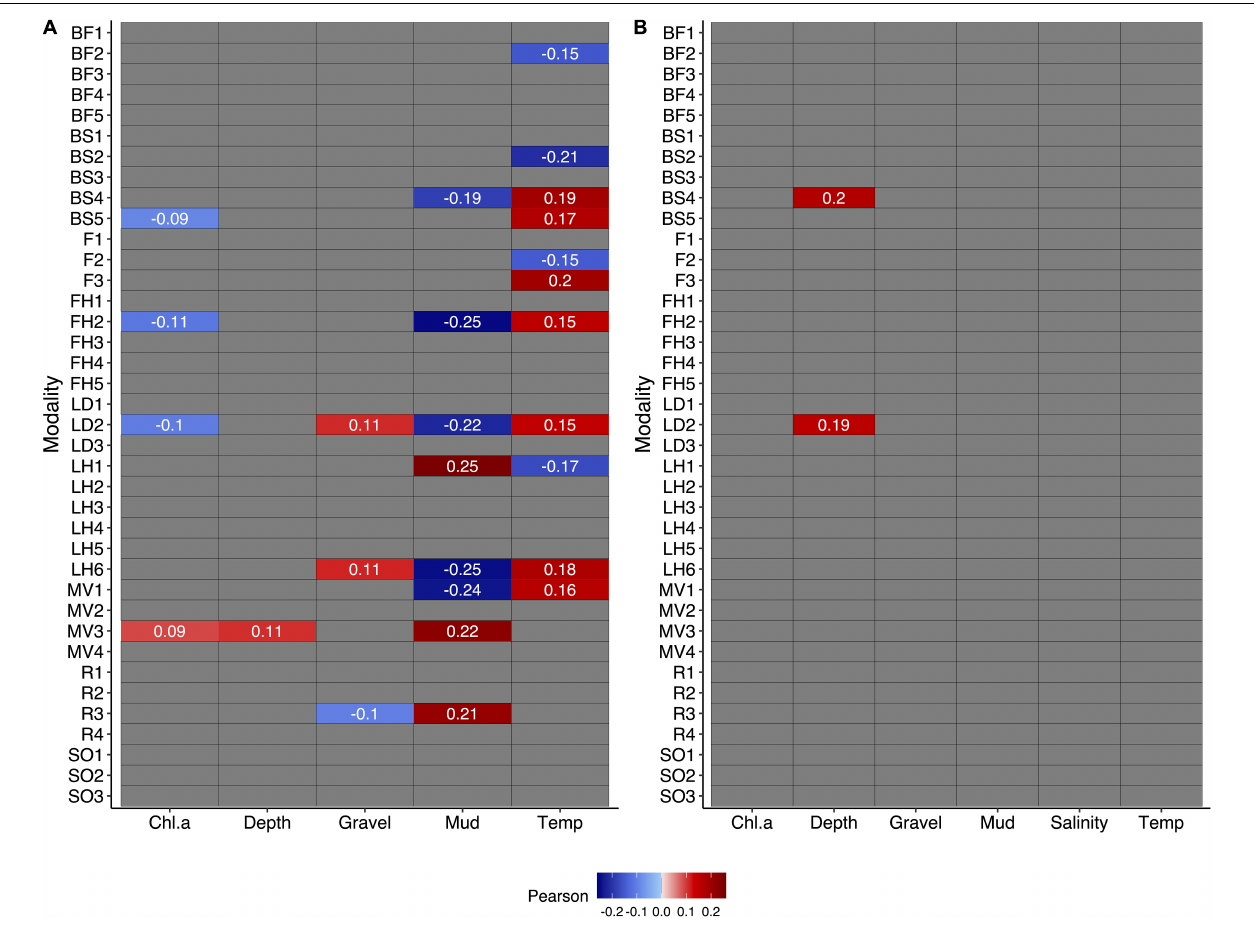
FIGURE 3 | Fourth corner tests show significant bivariate relationships between modalities and environmental variables for the Chukchi Sea (A) and the Beaufort Sea (B) . Significant positive relationships are represented by red colors and significant negative relationships are represented by blue colors. Gray colors indicate no significant relationships. Pearson correlation values are included for significant bivariate relationships with darker colors indicating stronger